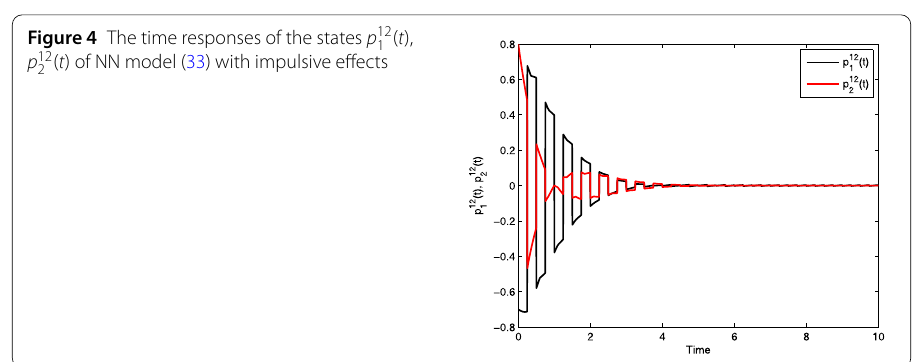
Figure 5 The time responses of the states p 0 1 ( t ), p 0 2 ( t ), p 1 1 ( t ), p 1 2 ( t ), p 2 1 ( t ), p 2 2 ( t ), p 12 1 ( t ), p 12 2 ( t ) in a 2-dimensional space with impulsive